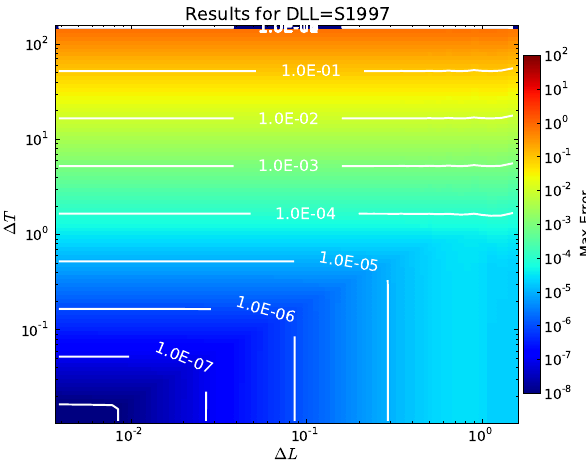
Fig. 6. Error map for 8000 simulations as a function of time step (vertical axis) and grid size (horizontal axis). White lines denote contours of constant error at each order-of-magnitude. These results were obtained using the S1997 D LL model. A cut of this map along a line of constant 1L ( 1t ) will yield a curve similar to what is seen in the top (bottom) frame of Fig. 5 with the slope indicating the order of convergence. The proper behavior is observed here over a large range of time steps and grid sizes. rows in Fig. 4 where the error reduction is less than expected given the second order solver. The center region of Fig. 5, delimited by the vertical dashed red lines, is known as the asymptotic regime. Here, the time step and grid size are both appropriate for the conditions being simulated and the error drops off as expected given the selected numerical scheme. The slope of this region is nearly equal to the order of the solver, indicating that the code is correctly solving the sys- tem as intended. The lower frame of Fig. 5 shows that the same is true when the grid resolution is refined. Figure 6 takes these results one step further. The number of simulations is now increased to 8000, and the error for each 1t - 1L combination is sorted into a two-dimensional color map. The white contour lines show order-of-magnitude boundaries clearly. Figure 6 not only confirms the results from above, but also reveals more about the code’s behavior for a particular D LL and Q MMS . For 1t > 1 s, refining the grid has almost no effect on the overall error. In this region, the contours are parallel to the 1L axis. This is because for a moderate value of D LL and a quickly varying source func- tion, it is much more important to have a properly refined time grid as opposed to a fine L grid. Only when the peri- odic source term is properly resolved does reducing the grid size improve results. The curve that passes through the in- tersection of the vertical and horizontal contours (not shown) traces the most efficient combinations of 1t and 1L . This information is important to code users who want to maximize code performance in terms of controlling error and maintain- ing fast run speeds; understanding the balance between the rate of variation in time and space is